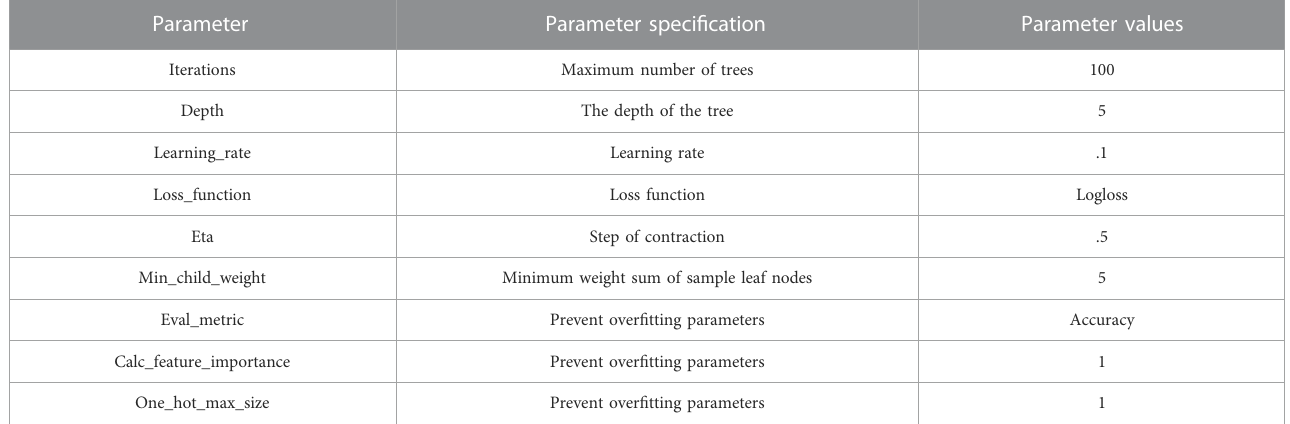
TABLE 3 The parameters of CatBoost